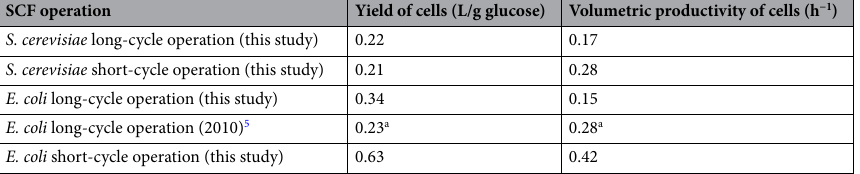
Table 1. Biomass yield and volumetric productivity during SCF long- and short-cycle operation. a Values were calculated based on original figure found in 5 using Eqs. (1) and (2).